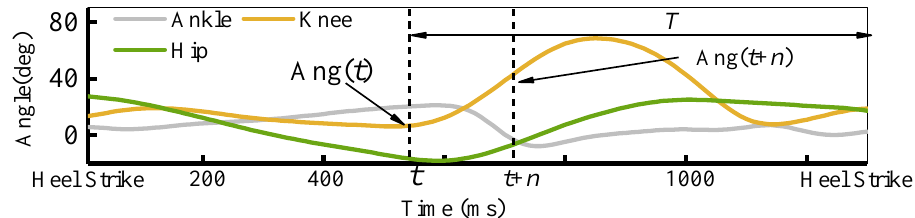
Figure 2. The lower limb joint angle and special event for a gait.